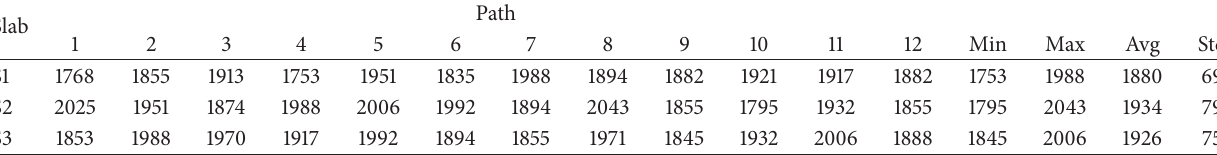
Table 4: R-wave velocities (m/s) along 12 paths in slabs S1, S2, and S3. Path